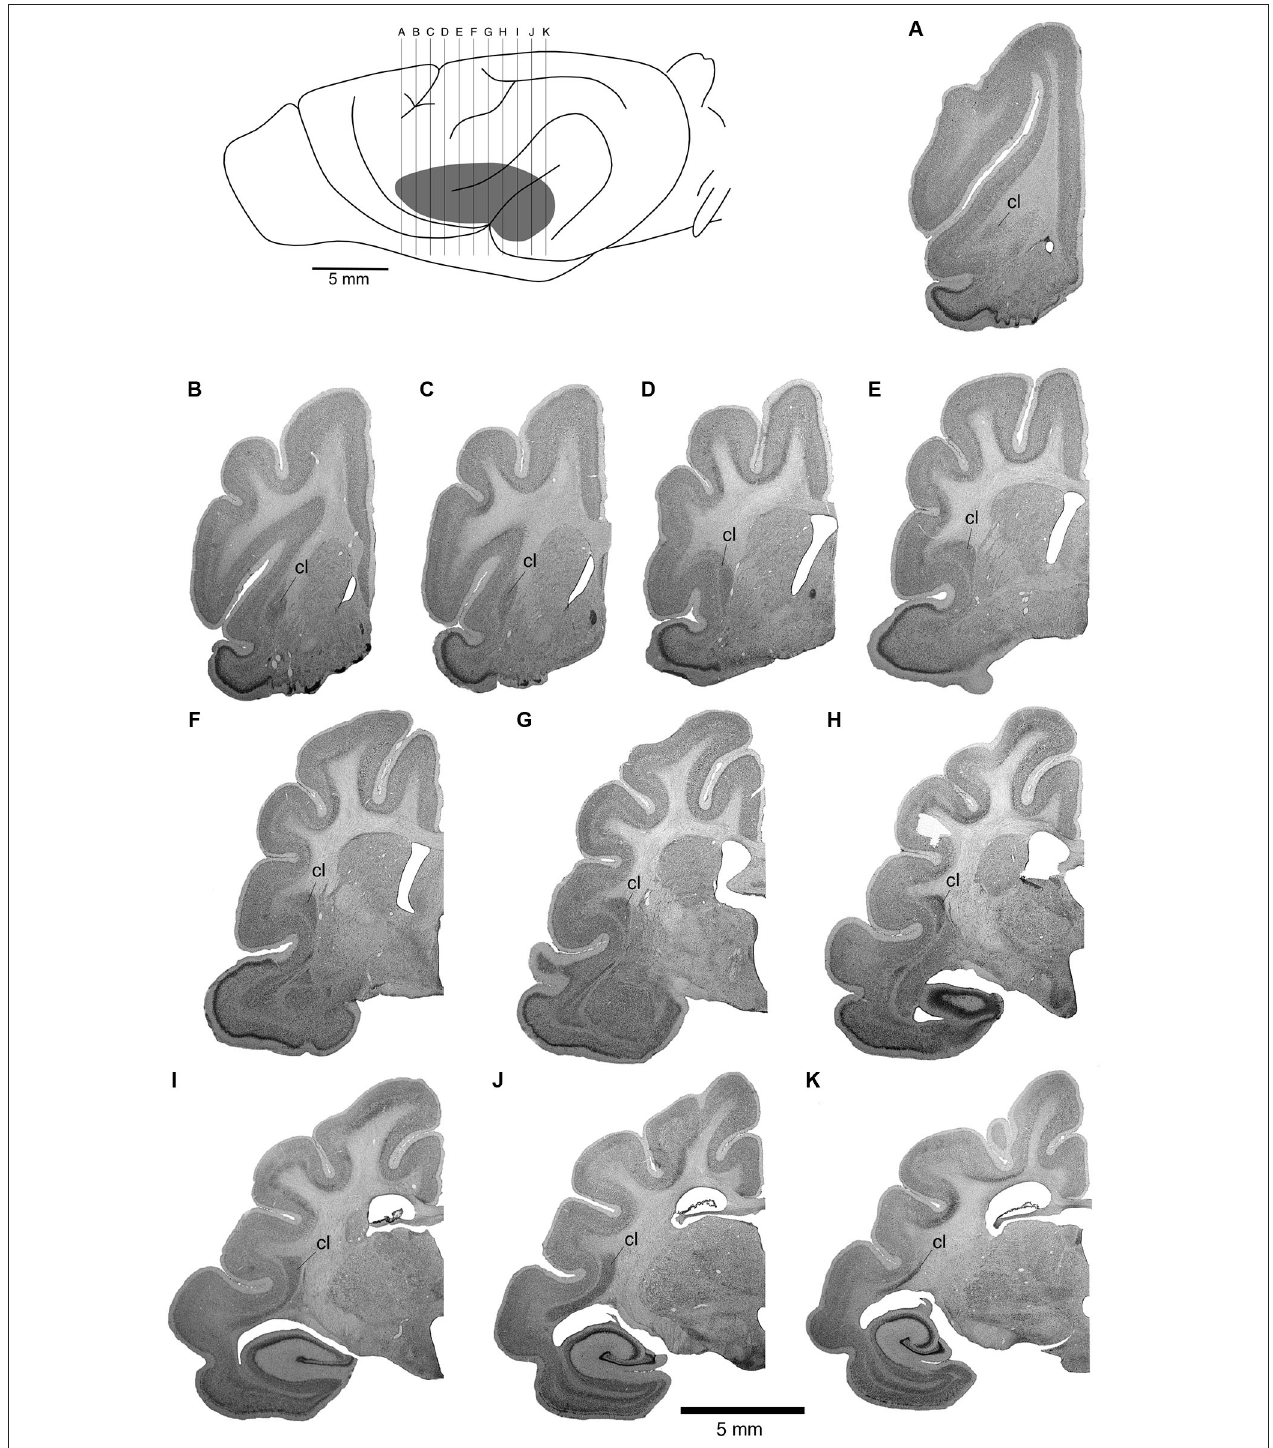
FIGURE 2 | Location of the ferret claustrum (cl) . The drawing of the lateral view of the ferret brain demarcates the location of the claustrum below the cerebral cortex, as well as the level of section corresponding to each of the images of the rostral to caudal Nissl stained sections A through K which are approximately 1 mm